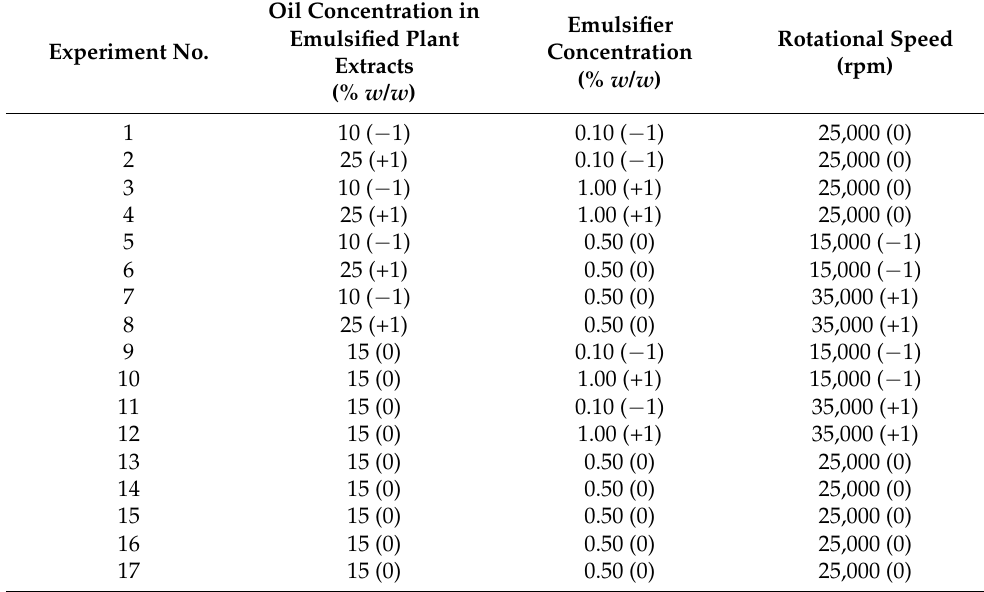
Table 7. Box–Behnken experimental design for emulsification